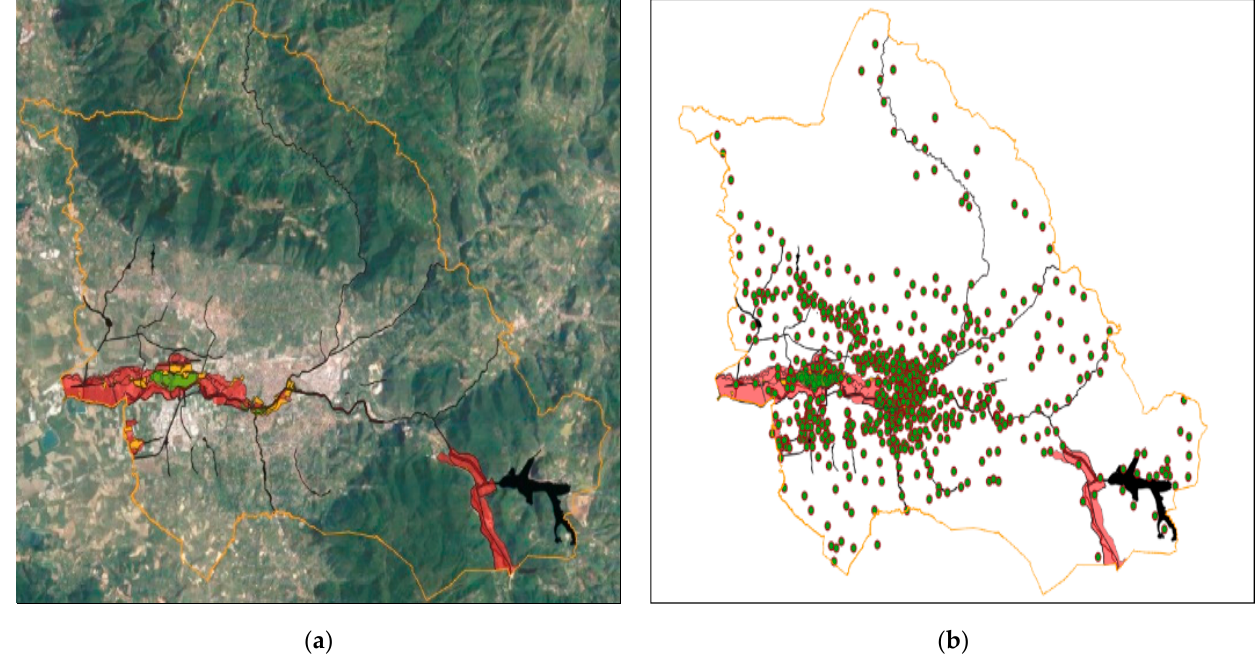
Figure 2. ( a ) Hydrogeological risk zones in Terni municipality according to [29,30] (red: Zone A; green: Zone B; yellow: Zone C; black: hydro basins); ( b ) SSs location in the hydrogeological risk zones (green bullets: SSs).